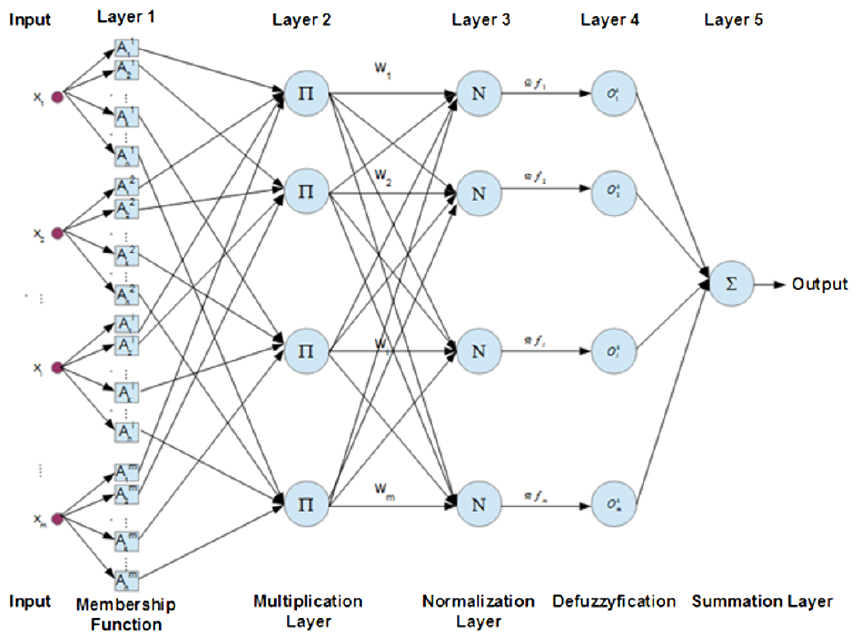
Figure 2. An ANFIS architecture for the Sugeno system used in this study (where m = 10, n = 2, i = 1 , 2 and k = 1 , 2 ,..., 10).